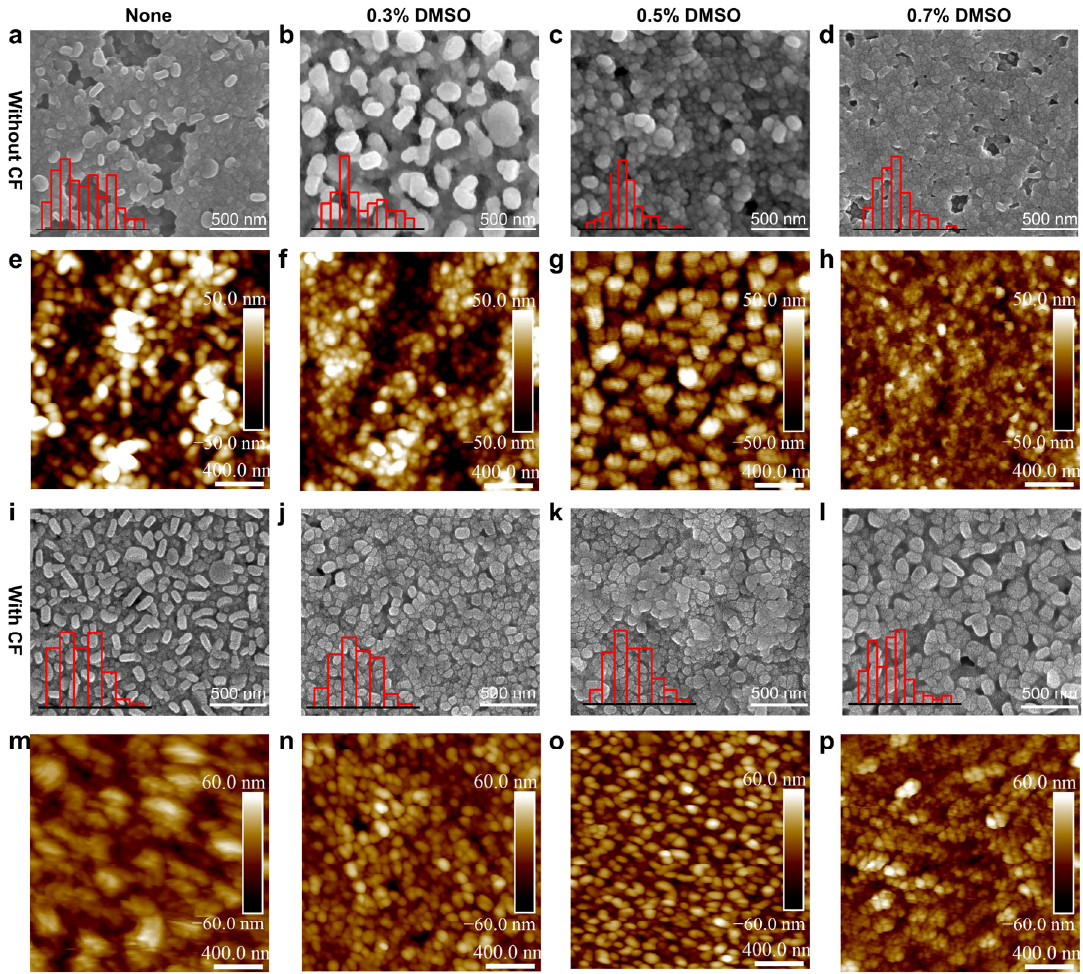
Figure 3. SEM ( a – d , i – l ) and AFM ( e – h , m – p ) images of BiI 3 films with different volume percentage of DMSO without and with CF anti-solvent treatment.